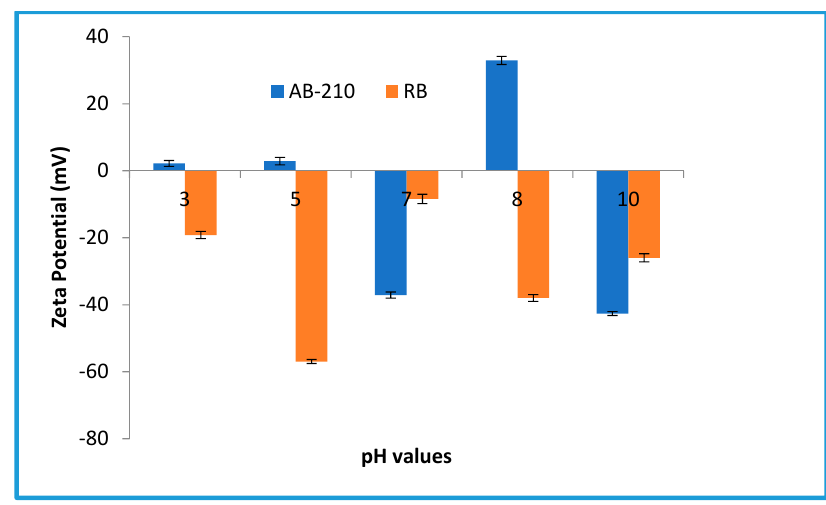
Figure 13. Effect of pH on the dye removal percent of membrane prepared from % 0.5 GO, at 3 bar, 25 °C, for AB ‐ 210 ( A ) and RB ( B ).